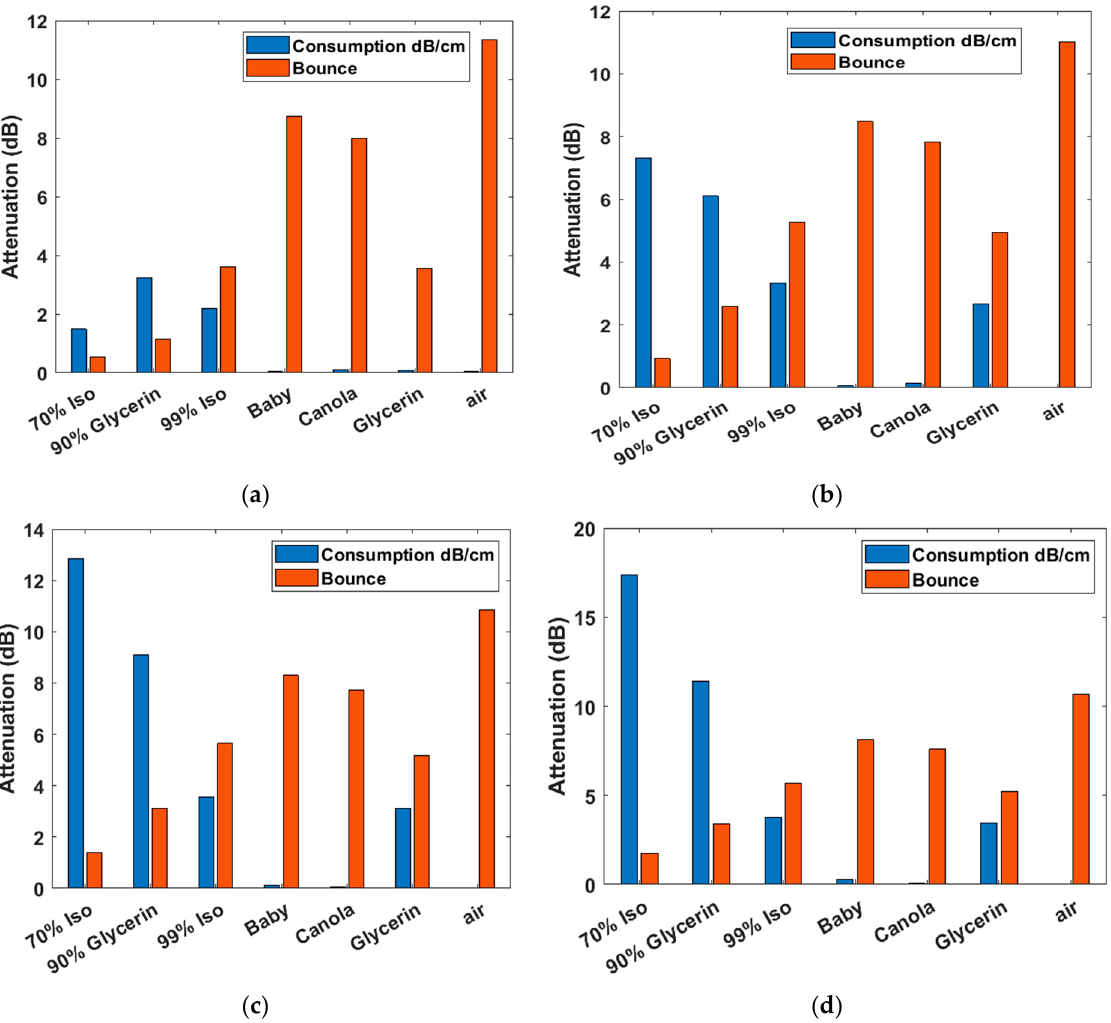
Figure 4. Plane wave attention due to consumption (dB/cm) in the lossy liquid shown in blue bars, and to the bounce back from skin shown in red bars, for the frequency ( a ) 1 GHz, ( b ) 3 GHz, ( c ) 5 GHz, and ( d ) 7 GHz.